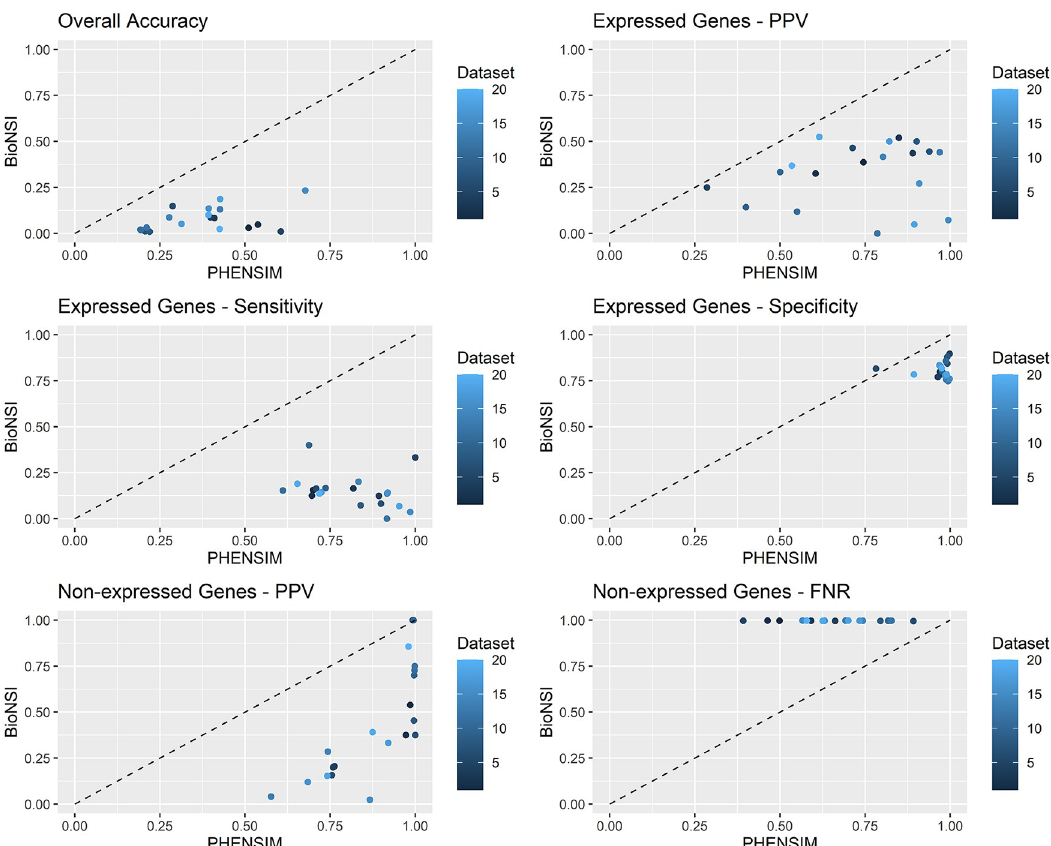
Fig 2. Comparison between PHENSIM and BioNSi for datasets where the altered gene was not in the meta-pathway. Each graph reports one metric: Positive Predictive Value (PPV), Sensitivity and Specificity for genes showing altered expression, and PPV and False Negative Rate (FNR) for the non-altered ones. On the x-axis, we report the PHENSIM performance, while on the y-axis, we have BioNSi. Each dot represents a dataset. The black line marks the points where the two algorithms have the same performance. On a dataset below the line, PHENSIM has better performance than BioNSi; above the line, it is the opposite. MAPK (activity score = -8.7121, p-value 0.113, perturbation = -3.193292579) and NF- κ B (NF- κ B perturbation = -0.0008) signaling were predicted downregulated. Furthermore, several downregulated enzymes and metabolites were correctly detected by PHENSIM (S3B Fig).